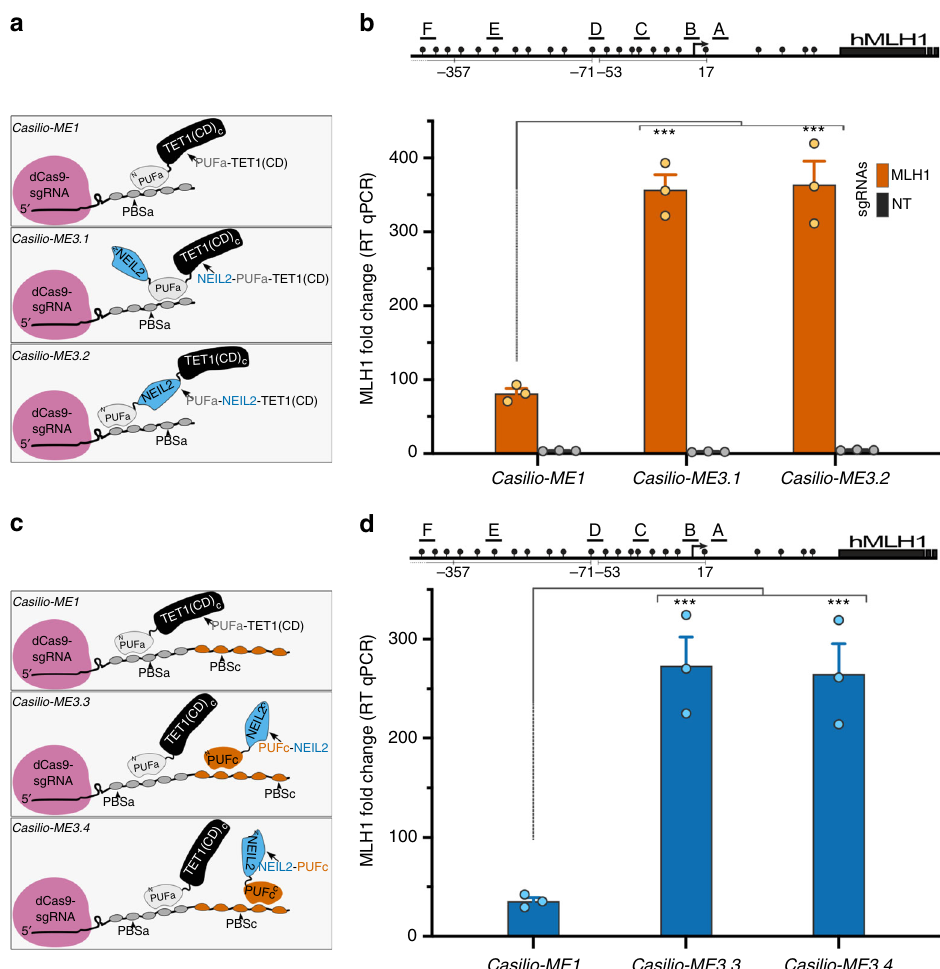
Fig. 3 Casilio-ME3 mediates dual delivery of TET1(CD) and NEIL2 to targeted genomic site. a Illustration of the indicated Casilio-ME platforms showing effector modules of PUFa fusion proteins used to transfect cells analyzed in panel (b). TET1(CD) (black), NEIL2 (blue), PUFa (light gray), occupancy of PBSa, amino (N) and carboxyl (C) termini of protein fusions are arbitrarily shown. b MLH1 mRNA relative levels (mean fold change ± S.E.M.; n = 3) in cells transfected with components of Casilio-ME1, Casilio-ME3.1, or Casilio-ME3.2 in the presence MLH1 -sgRNAs or NT-sgRNA as indicated. Drawing of promoter regions with the MLH1 -sgRNAs used (A-F), CpGs (lollipops), and TSS (arrow) is shown above the plot. *** p < 0.001, one-way ANOVA. c Schematic representation of the indicated Casilio-ME platforms showing effector modules of PUFa and PUFc protein fusions used to transfect cells analyzed in panel (d). TET1(CD) (black), NEIL2 (blue), PUFa (light gray), PUFc (orange), sgRNA containing both PBSa and PBSc, occupancy of PBSa and PBSc, amino (N) and carboxyl (C) termini of protein fusions are arbitrarily shown. d Plot showing MLH1 mRNA relative levels (mean fold change ± S.E.M.; n = 3) in cells transfected with components of Casilio-ME1, Casilio-ME3.3, or Casilio-ME3.4 in the presence of MLH1- sgRNAs. Drawing of promoter regions with the MLH1 - sgRNAs used (A-F), CpGs (lollipops), and TSS (arrow) is shown above the plot. *** p < 0.005, one-way